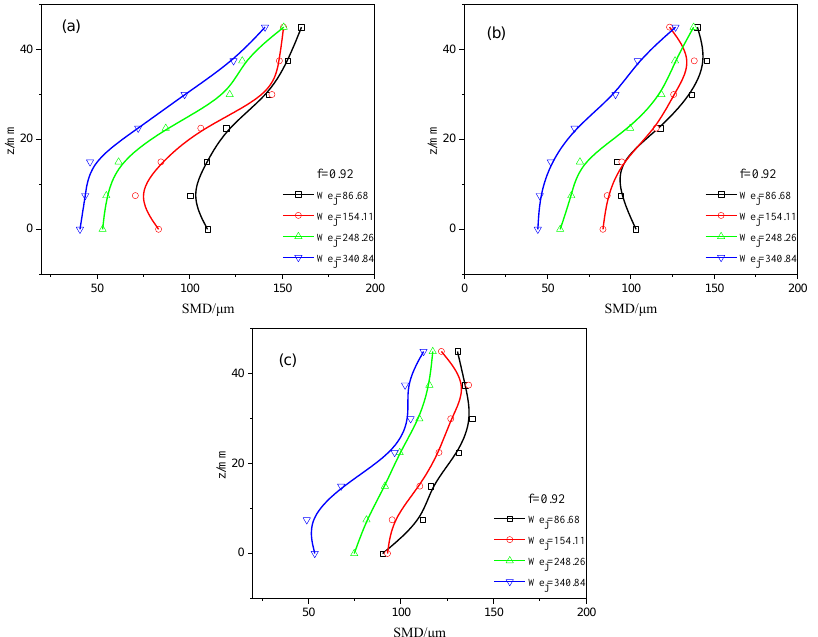
Figure10. Dropletsizedistributionalongthezdirectionfordi ff erentWe j atthesameWe g , ( a ) We g = 4.64, Figure 10. Droplet size distribution along the z direction for different We j at the same We g , ( a ) We g = ( b ) We g = 6.19, ( c ) We g = 4.64, ( b ) We g = 6.19, ( c ) We g = 7.55.